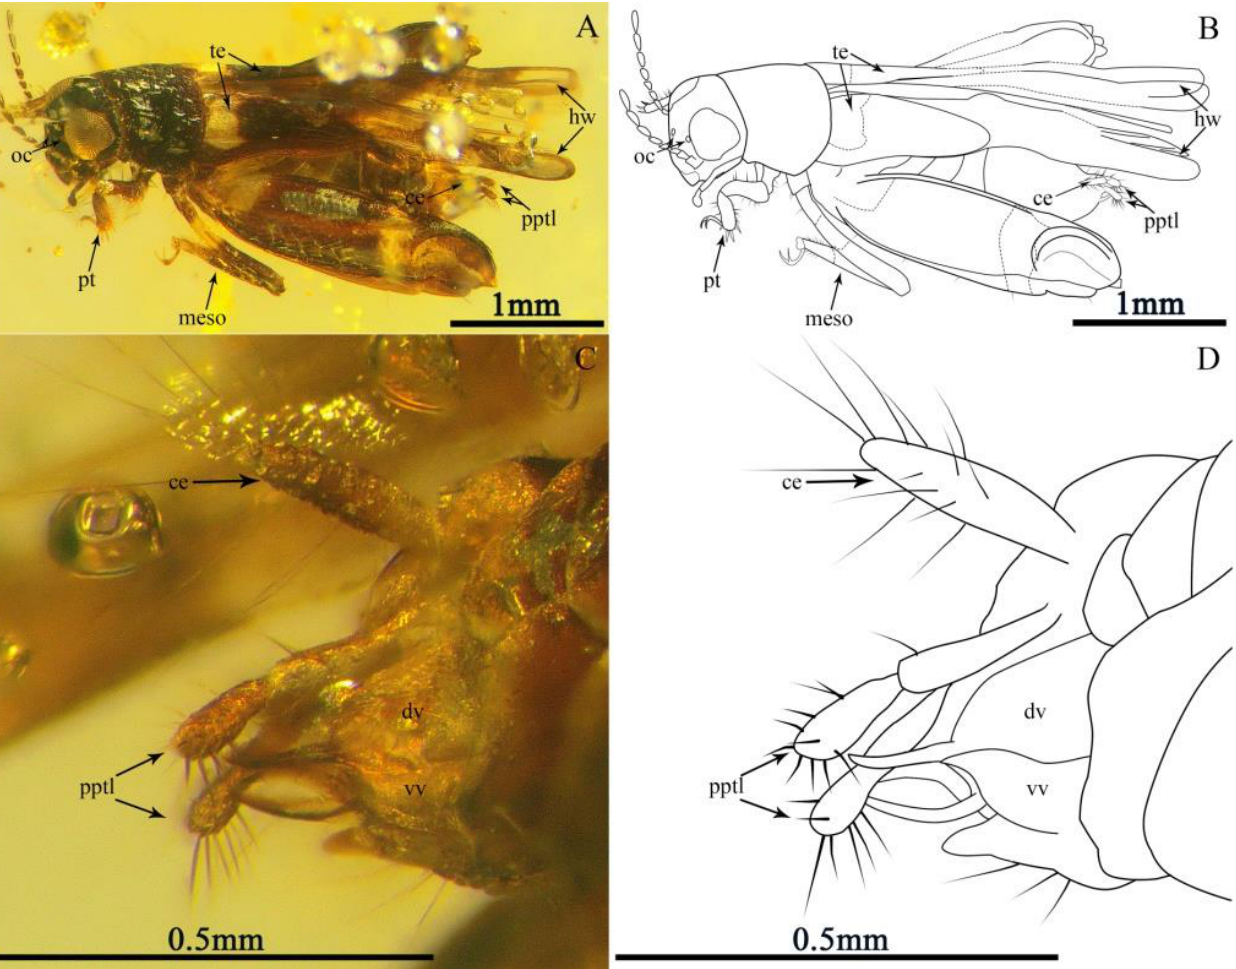
Figure 1. Holotype (CNU-ORT-MA2016021) of Magnidactylus mirus sp. nov., holotype; ( A ) photo- graph of the habitus in the dorsal-lateral view, ( B ) line drawing of the habitus, ( C ) photograph of the terminal abdomen, and ( D ) line drawing of the terminal abdomen.